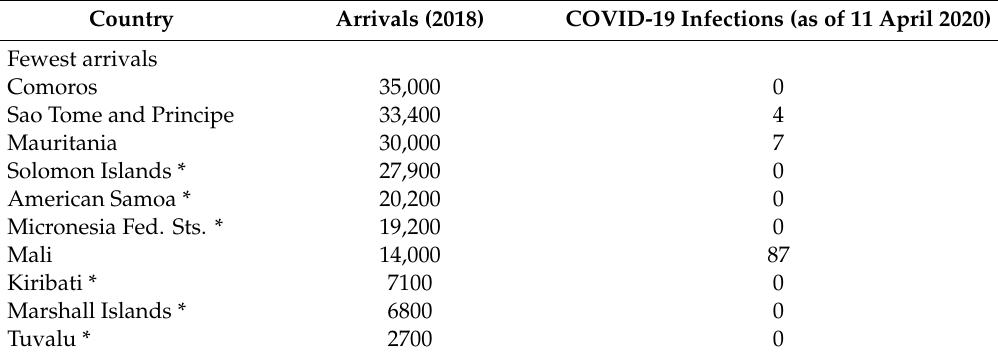
Table 2. World’s top-ten least-visited countries (fewest international arrivals according to the UN World Tourism Organization; 2018—the most recent year available) and COVID-19 infection